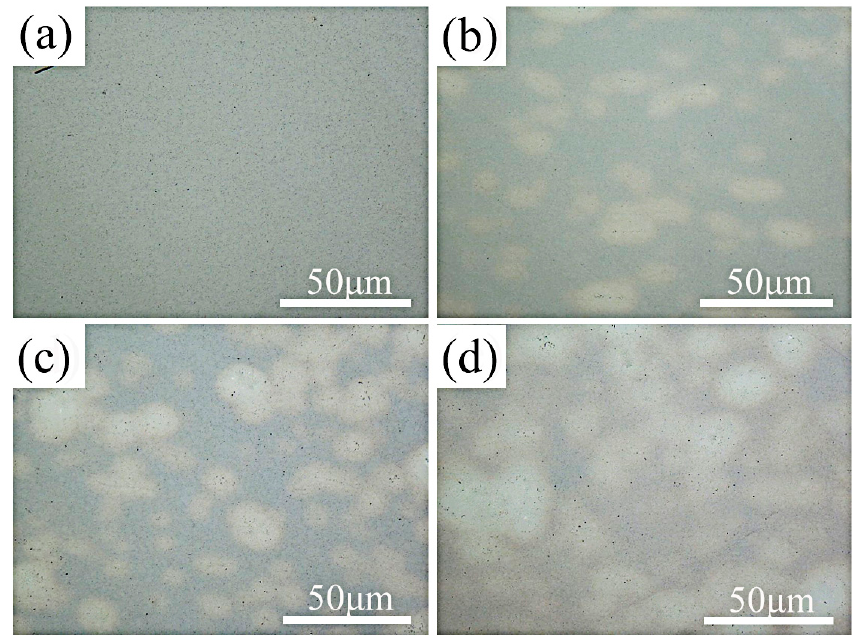
Figure 3. OM images of the composites: ( a ) 0 wt.% HEA; ( b ) 5 wt.% HEA; ( c ) 10 wt.% HEA; and ( d ) 15 wt.% HEA.